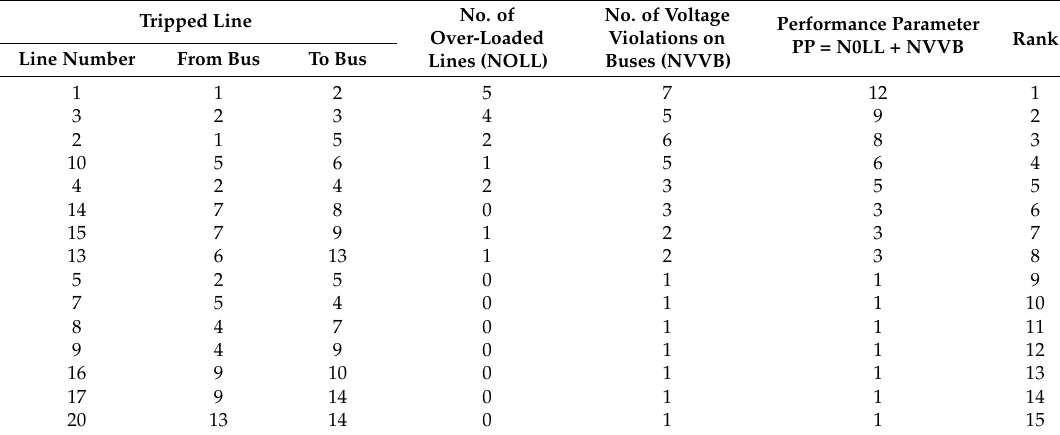
Table 3. Contingency Analysis with Performance Parameter and Ranking